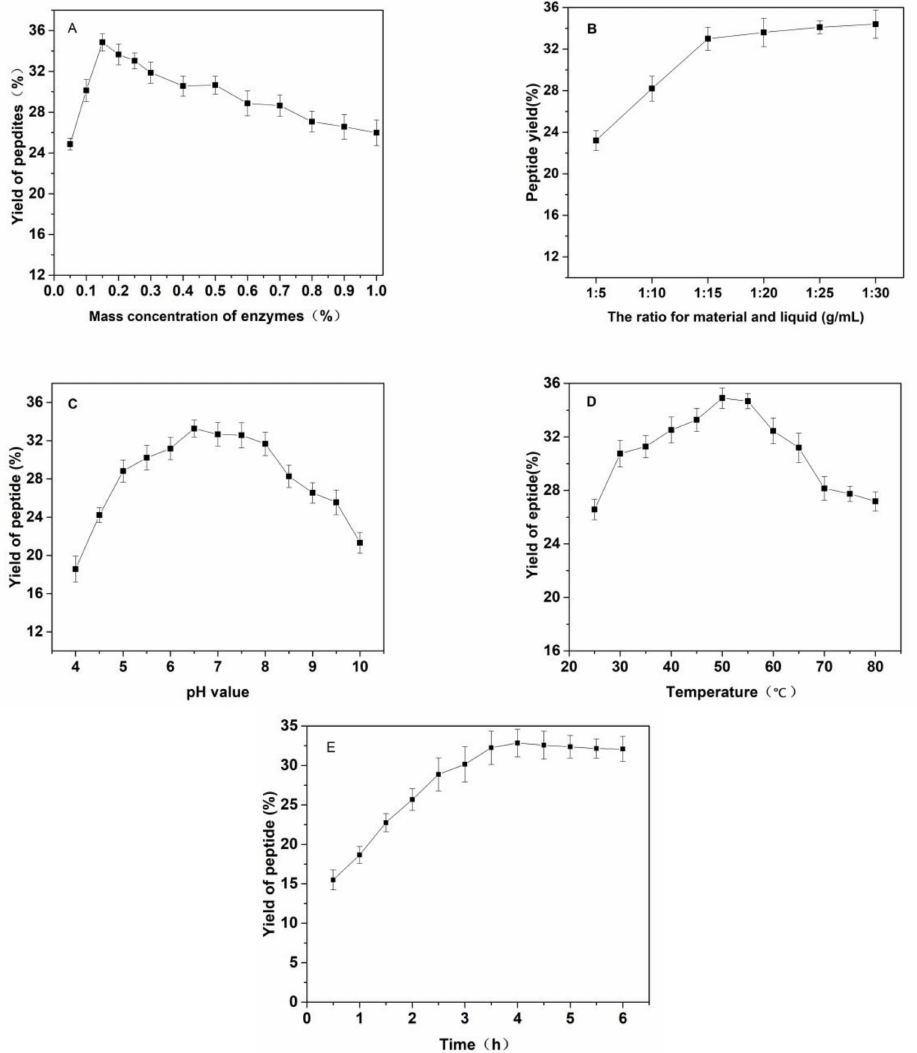
Figure 3. Effects of ( A ) the substrate ratio of enzymes (%), ( B ) the ratio for materials and liquid (g/mL), ( C ) pH, ( D ) temperature ( ◦ C) and ( E ) reaction time (h) on the yield of Cornus officinalis